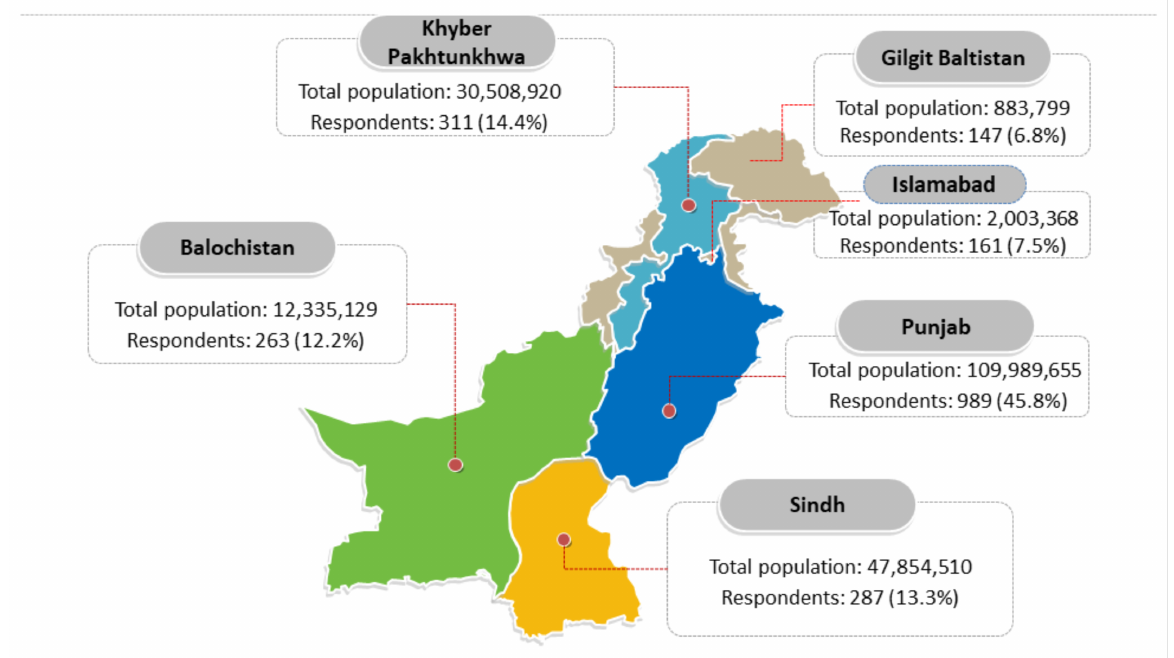
Figure 1. Provincial distribution of the respondents (source: Pakistan Bureau of Statistics) [43]. Table 2. Beliefs of participants towards myths or conspiracy theories regarding the COVID-19